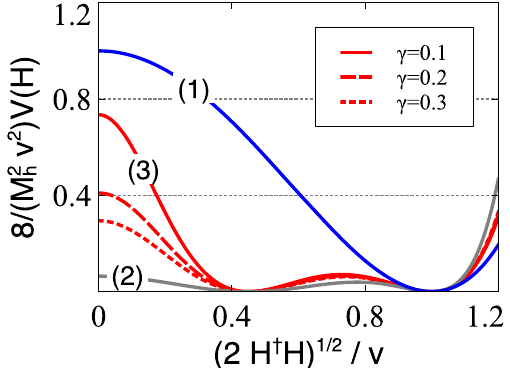
Fig. 1 Isospin averaged baryon masses as a function of r = m s / m phys s along the Higgs trajectory with 2 m s /( m u + m d ) = 26 kept constant